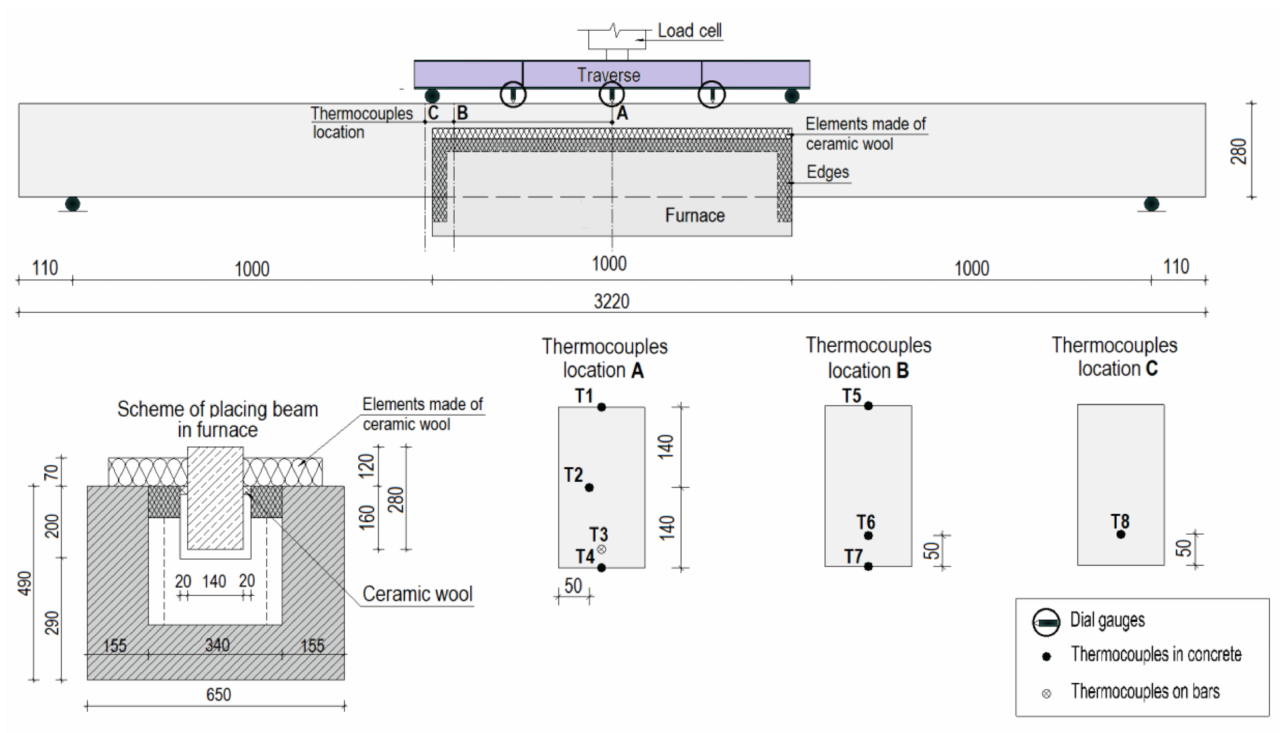
Figure 2. Test setup